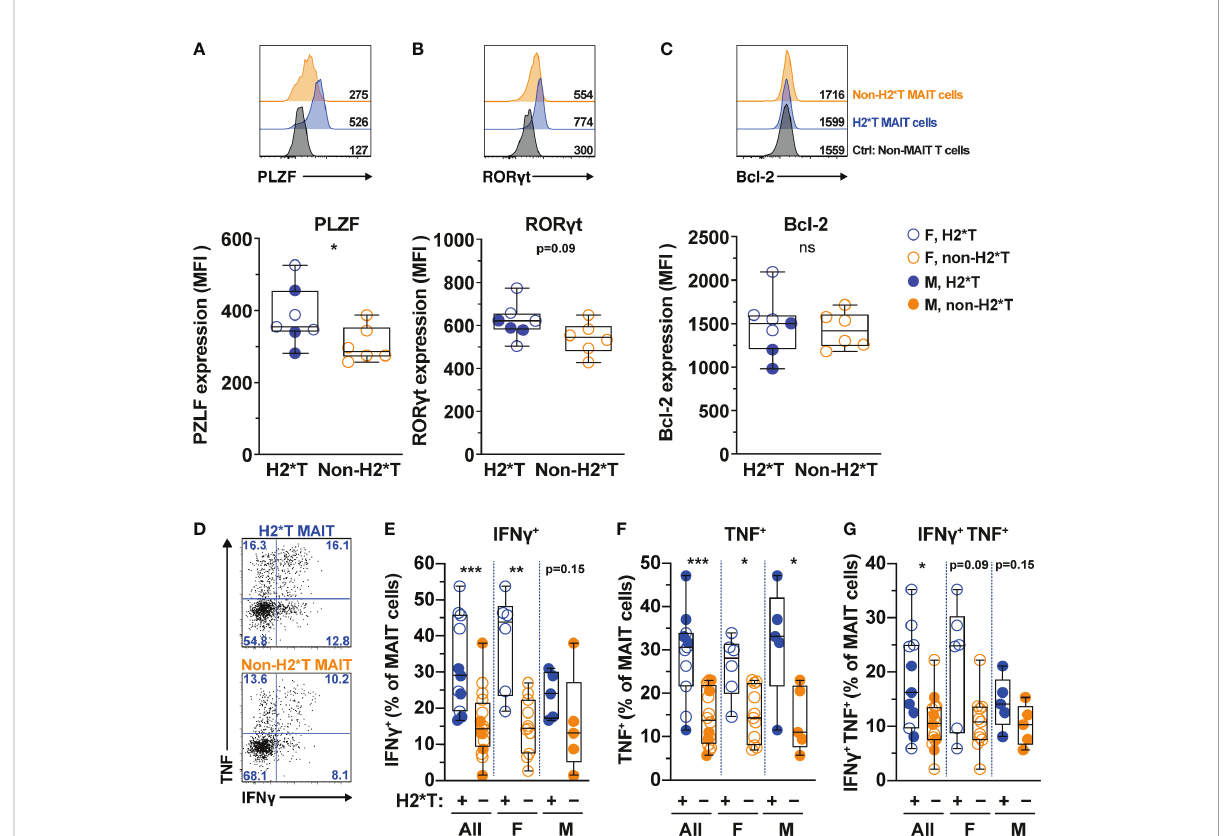
FIGURE 2 MAIT cells from HIV-1-uninfected individuals carrying IL7RA haplotype 2 express higher levels of MAIT cells-associated transcription factors and effector function. (A – C) Representative histograms for PLZF (A) , ROR g t (B) , and Bcl-2 (C) levels in V a 7.2 + CD161 hi MAIT cells in HIV-1-uninfected individuals bearing the different IL-7R a haplotypes. Non-MAIT T cells represent all other non-MAIT, CD3 + T cells (D – G) Representative fl ow cytometry gating strategy (D) to enumerate IFN g (E) , TNF (F) , and dual IFN g -TNF (G) production by MAIT cells following 24 h stimulation with formaldehyde- fi xed E coli (bacterial dose 1 CFU/cell). Box and whisker plots show all data points (N=7-11 for haplotype 2 individuals and N=6- 16 for non-haplotype 2), median, and the interquartile range. Statistical signi fi cance was determined using Mann-Whitney ’ s test. *** p<0.001, ** p<0.01,* p<0.05. ns, not signi fi cant. F, female; M, male; H2*T, IL7RA haplotype